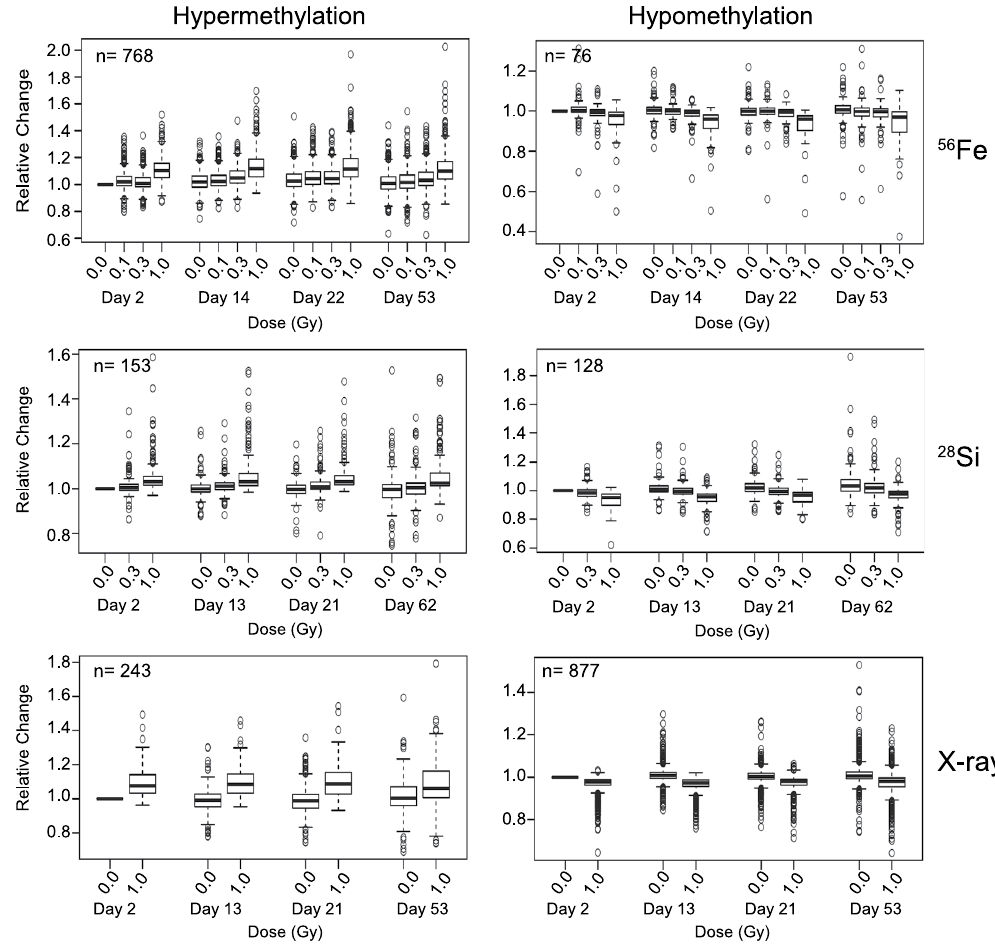
Figure 3. Fate of Radiation-induced changes in DNA methylation over time. CpG sites exhibiting a change in methylation level significantly associated with radiation dose were normalized to their individual initial methylation levels as extrapolated from the 48 h, unexposed cultures. Shown is the distribution of the change in methylation of CpG sites undergoing hyper- or hypo-methylation in response to the indicated radiation source relative to the internal control (unexposed) cultures at 48 h. Line represents the median, boxes the first and third quartile, and whiskers extend to maximum value that is 1.5 times the interquartile range. For clarity, CpG sites whose methylation level was also independently associated with time-after-culture were excluded. Note that irradiation-induced methylation changes occur early (within 48 h) and largely persist over